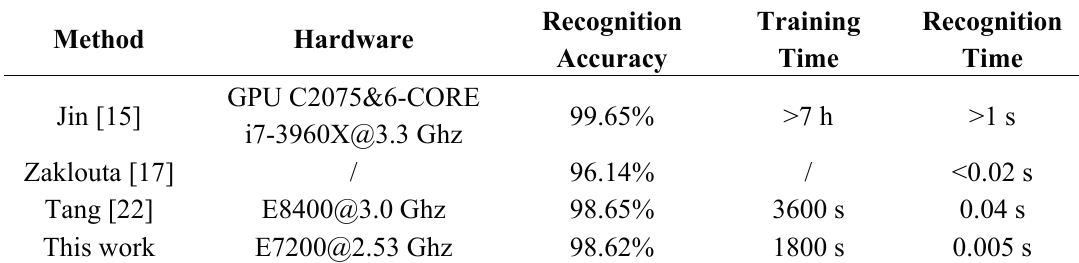
Table 8. Comparison with other works for the GTSRB data set.